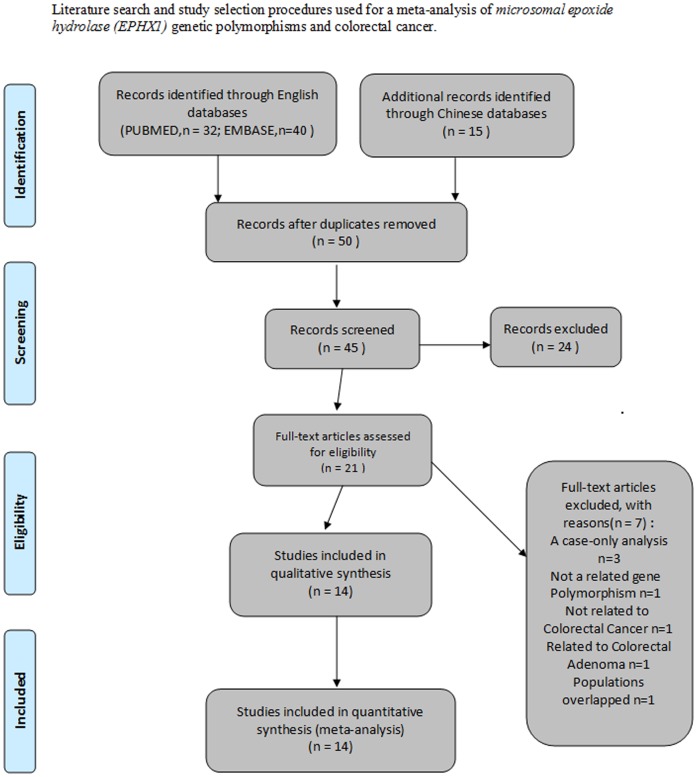
Literature search and study selection procedures used for a meta-analysis of microsomal epoxide hydrolase (EPHX1) genetic polymorphisms and colorectal cancer.